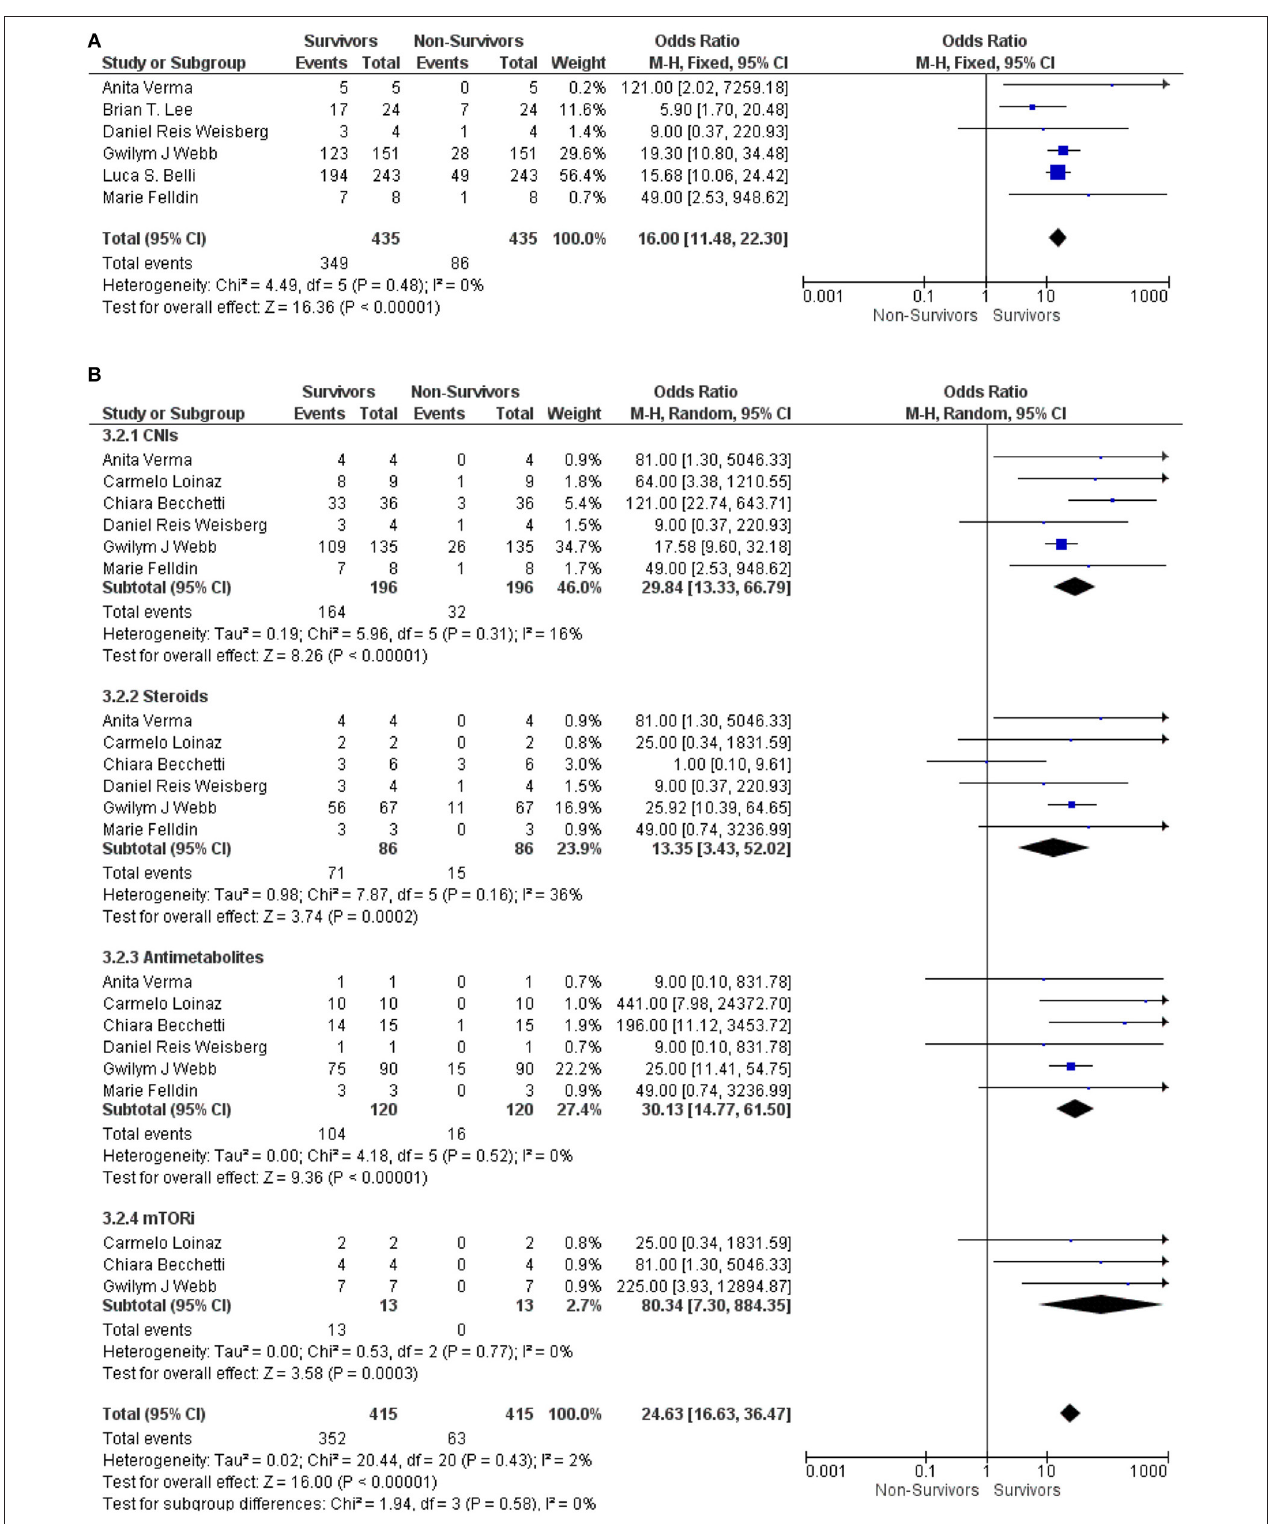
FIGURE 3 | (A) Forest plots for an association between the survivors and non-survivors LT recipients with COVID-19 for the overall ISs. (B) Forest plots for an association between the survivors and non-survivors LT recipients with COVID-19 with subgroup analysis for the CNIs, steroids, antimetabolites, and mTORis therapy.